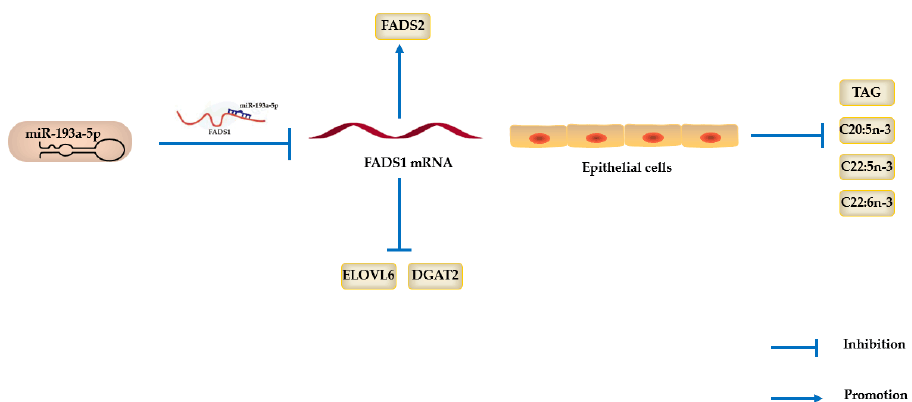
Figure 9. MiRNA-193a-5p regulated the synthesis of eicosapentaenoic acid (EPA), docosapentaenoic acid (DPA) and docosahexaenoic acid (DHA) by targeting FADS1 in BMECs. After transfecting the miRNA-193a-5p mimics into BMECs, FADS1 expression was downregulated, which led to the upregulation of FADS2 and the downregulation of ELOVL6 and DGAT2